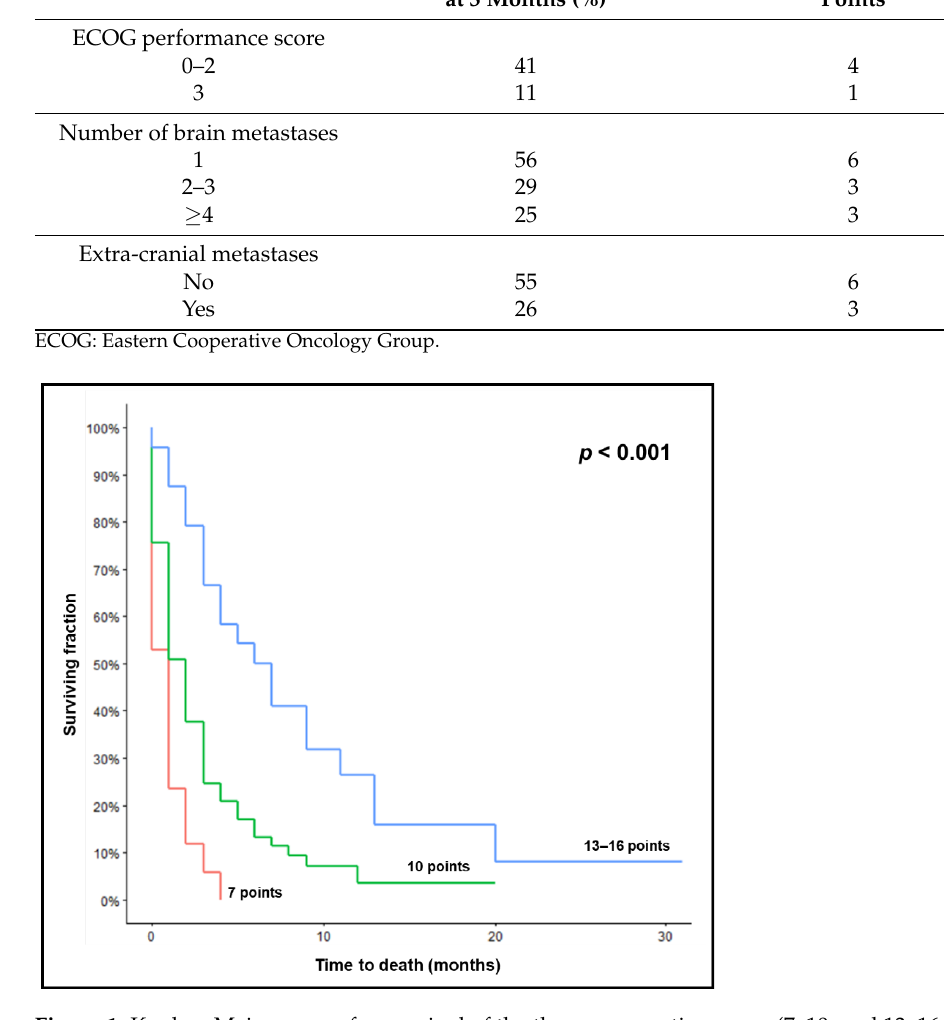
Figure 1. Kaplan – Meier curves for survival of the three prognostic groups (7, 10, and 13 – 16 points). Figure 1. Kaplan–Meier curves for survival of the three prognostic groups (7, 10, and 13–16 points). p -value was calculated using the log-rank test. p -value was calculated using the log-rank Table 4. Three prognostic groups and corresponding survival rates at 1, 2, 3, and 6 months.